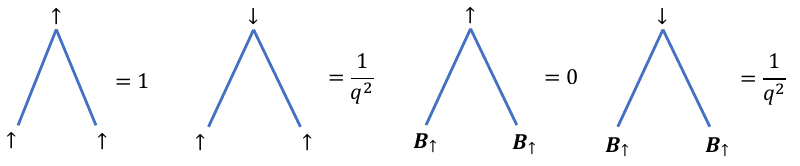
Figure 19 . Rules for interactions along the bottom boundary.